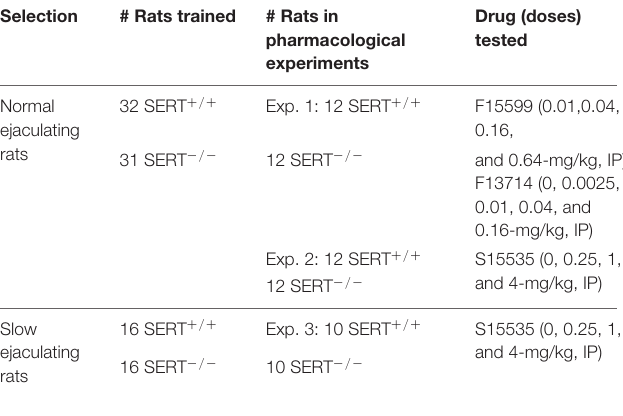
TABLE 1 | Overview of training of the various genotypes and pharmacological experiments in selected male